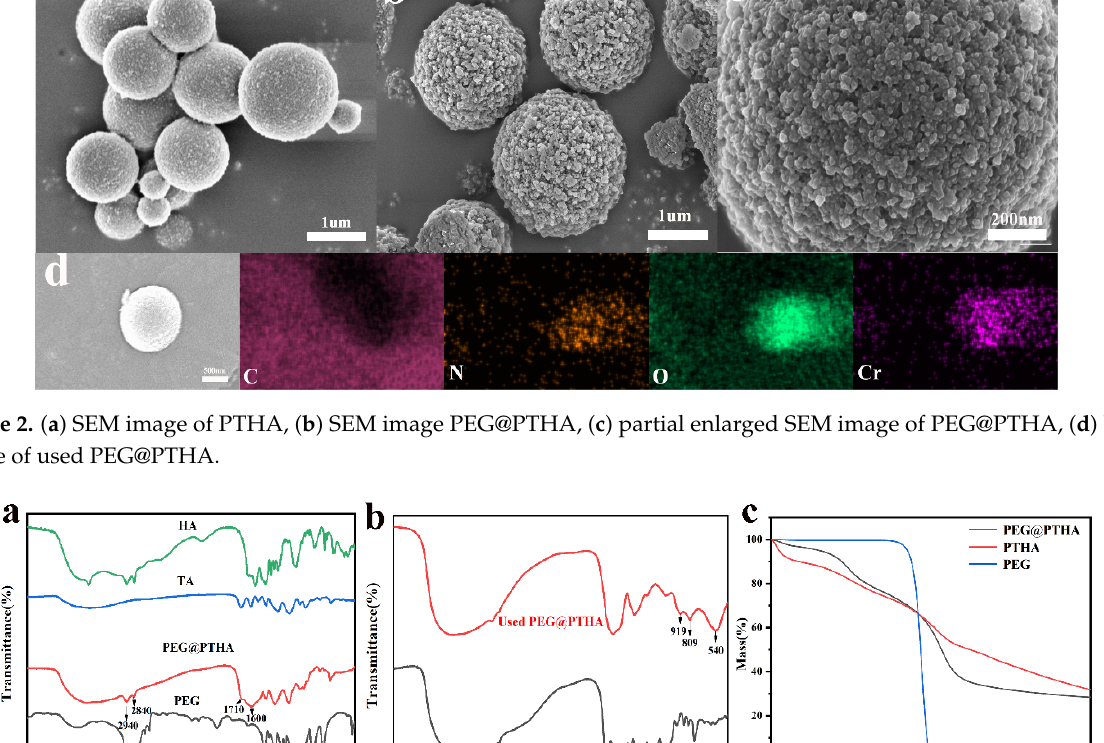
Figure 2. ( a ) SEM image of PTHA, ( b ) SEM image PEG@PTHA, ( c ) partial enlarged SEM image of PEG@PTHA, ( d ) EDS image of used PEG@PTHA.